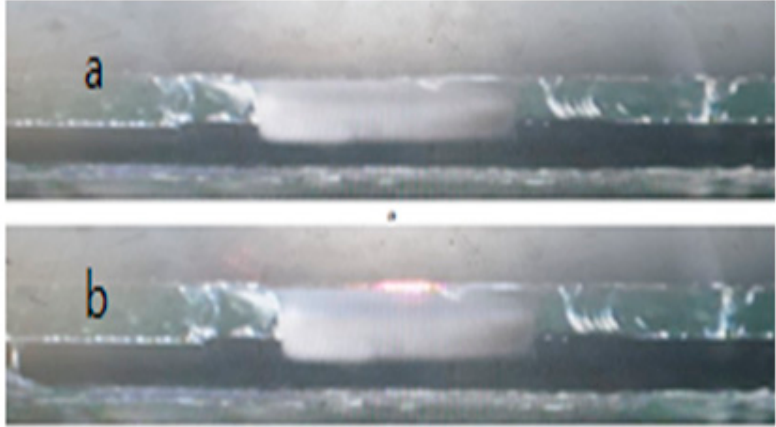
Figure 8. ( a ) Exit view from CCD camera without incident light beam ( b ) the zeroth order light beam at exit without SAW perturbation.